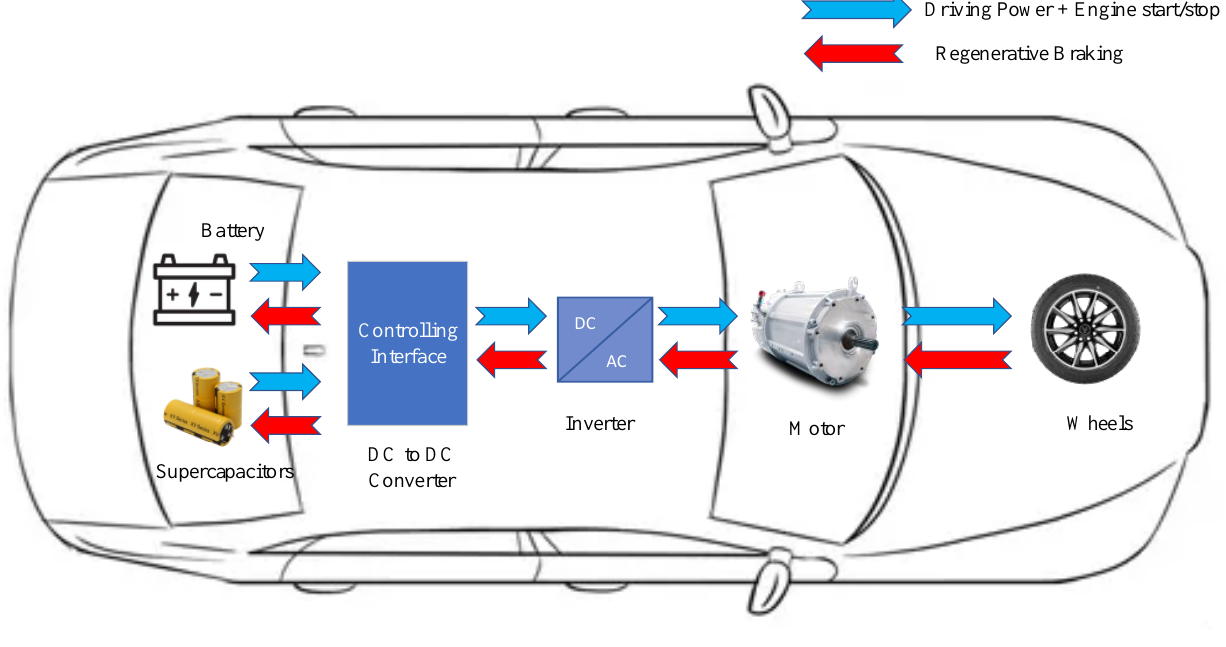
Figure 5. Power management in an electric vehicle.